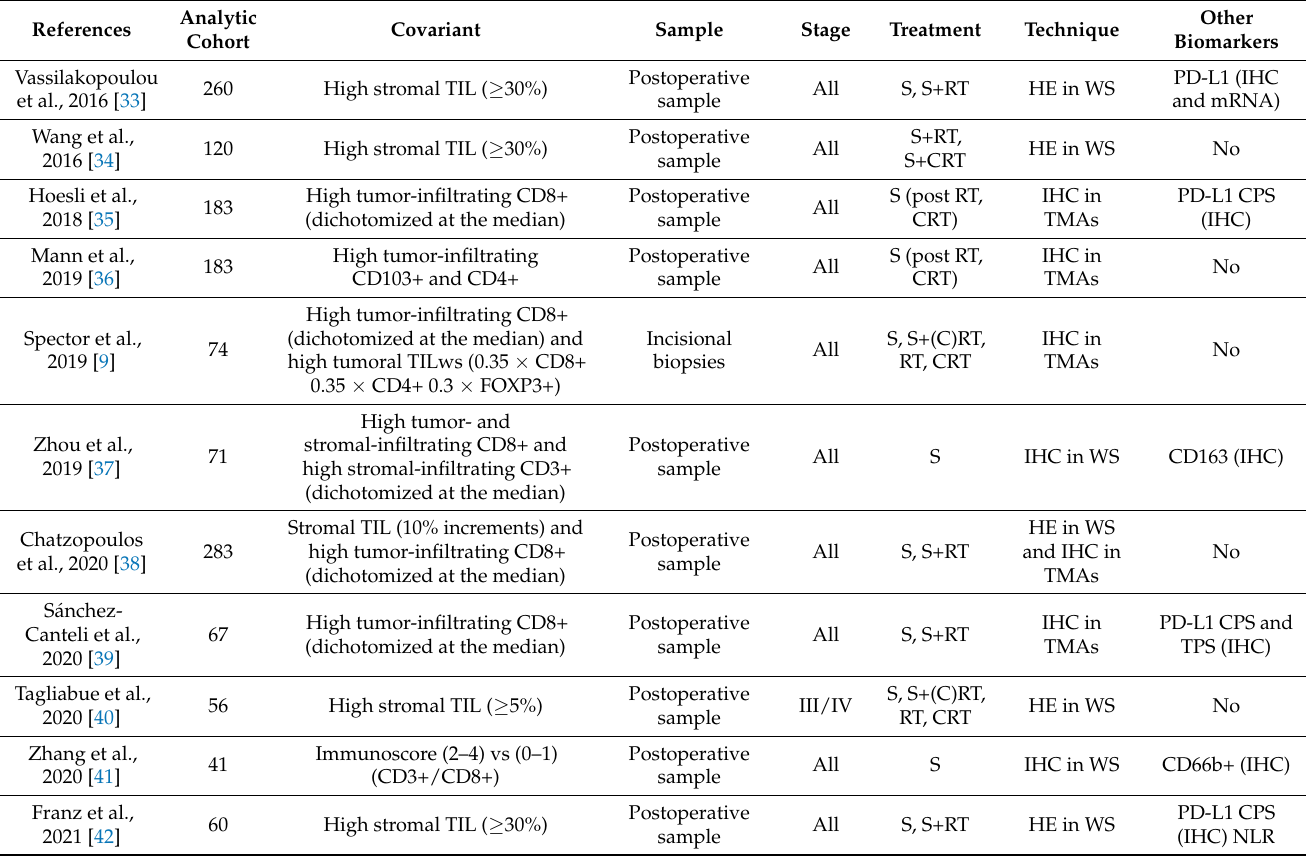
Table 1. Main features of the selected studies.